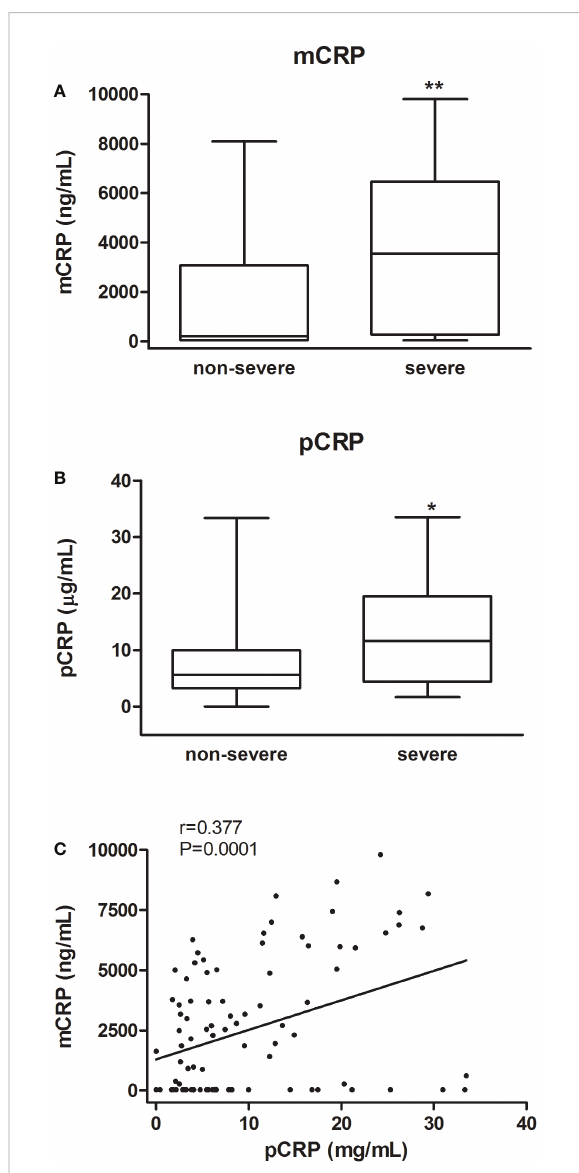
FIGURE 1 mCRP and pCRP levels in COVID-19 patients. Box-and whisker plots of mCRP (A) and pCRP (B) levels according to disease severity (ICU-admission and/or in-hospital mortality). Median values are highlighted by solid lines. Statistical analysis was conducted using Mann-Whitney test (*P < 0.05, **P < 0.001). Correlation between mCRP and pCRP (C) .